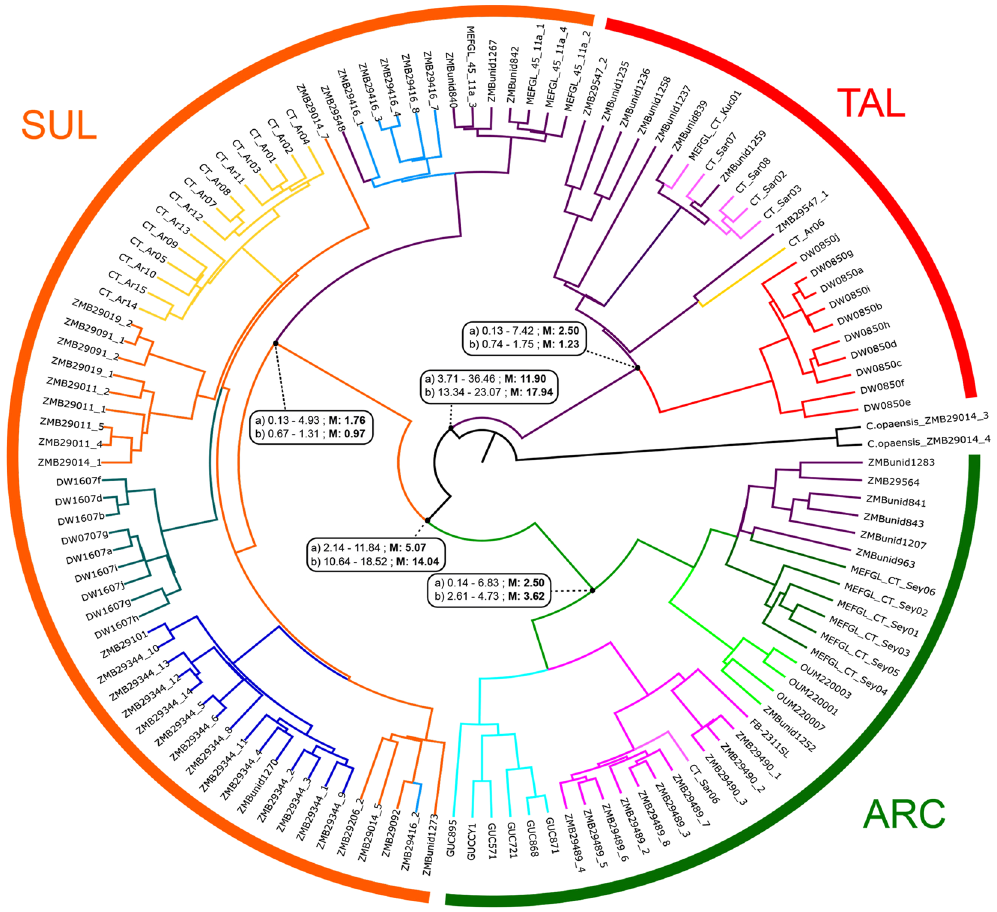
Figure 2. Time-calibrated phylogenetic and phylogeographic relationships in C . typus rooted using C . opaensis . Dates are represented as millions of years before present. The main nodes, i.e., those that represent divergence between the major clades and origins of the diversification within them, are labelled with 95% confidence intervals for their dates as well as its median (M). Each label carries the date obtained through data from all markers ( a ) as well as the one obtained solely through mtDNA data ( b